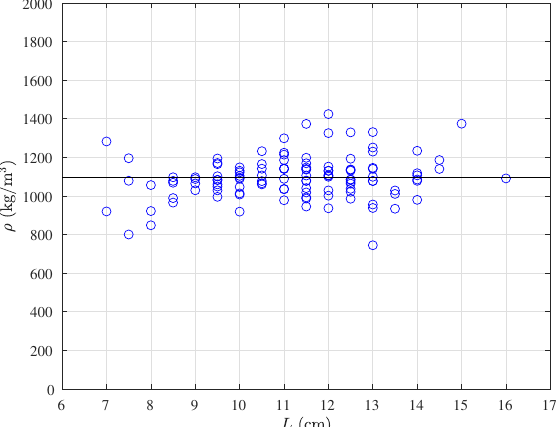
Figure 9. Density of Asterias rubens calculated for each individual. The solid line corresponds to the mean density.